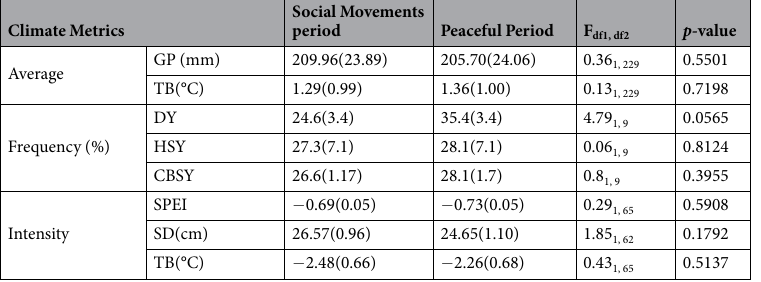
Table 1. Comparison of Frequency and Intensity of Three Climate Hazards in Social Movement period and peaceful period. Note: GP, TB, DY, HSY, CBSY, SPEI, SD, and CBP stand for growing season precipitation, annual mean temperature, dry years, heavy snowfall years, cold breeding season year, standardized precipitation evapotranspiration index, snow depth, and cold breeding season events respectively. There were no significant differences in climate conditions between peaceful and social movement periods.